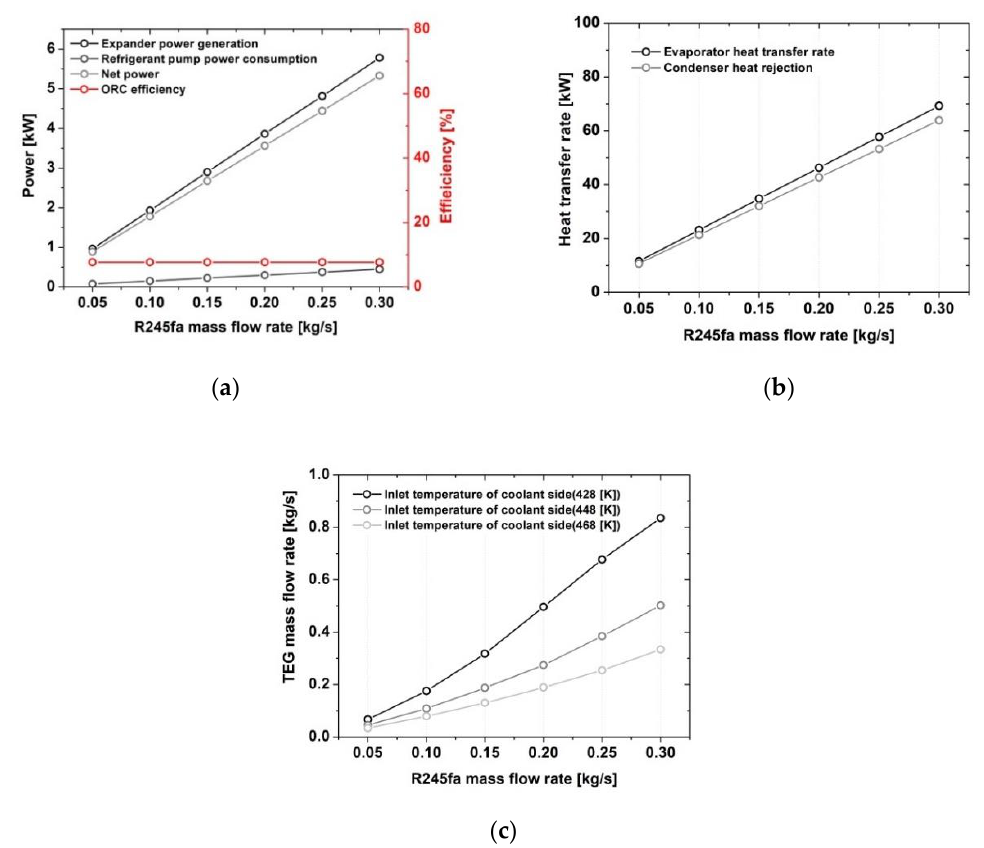
Figure 7. ORC system performance curve according to R245fa mass flow rate. ( a ) Electric power; ( b ) Evaporator and condenser heat transfer rate; ( c ) Mass flow rate of Tri-ethylene glycol (TEG) that satisfies superheat 5 K in the evaporator.